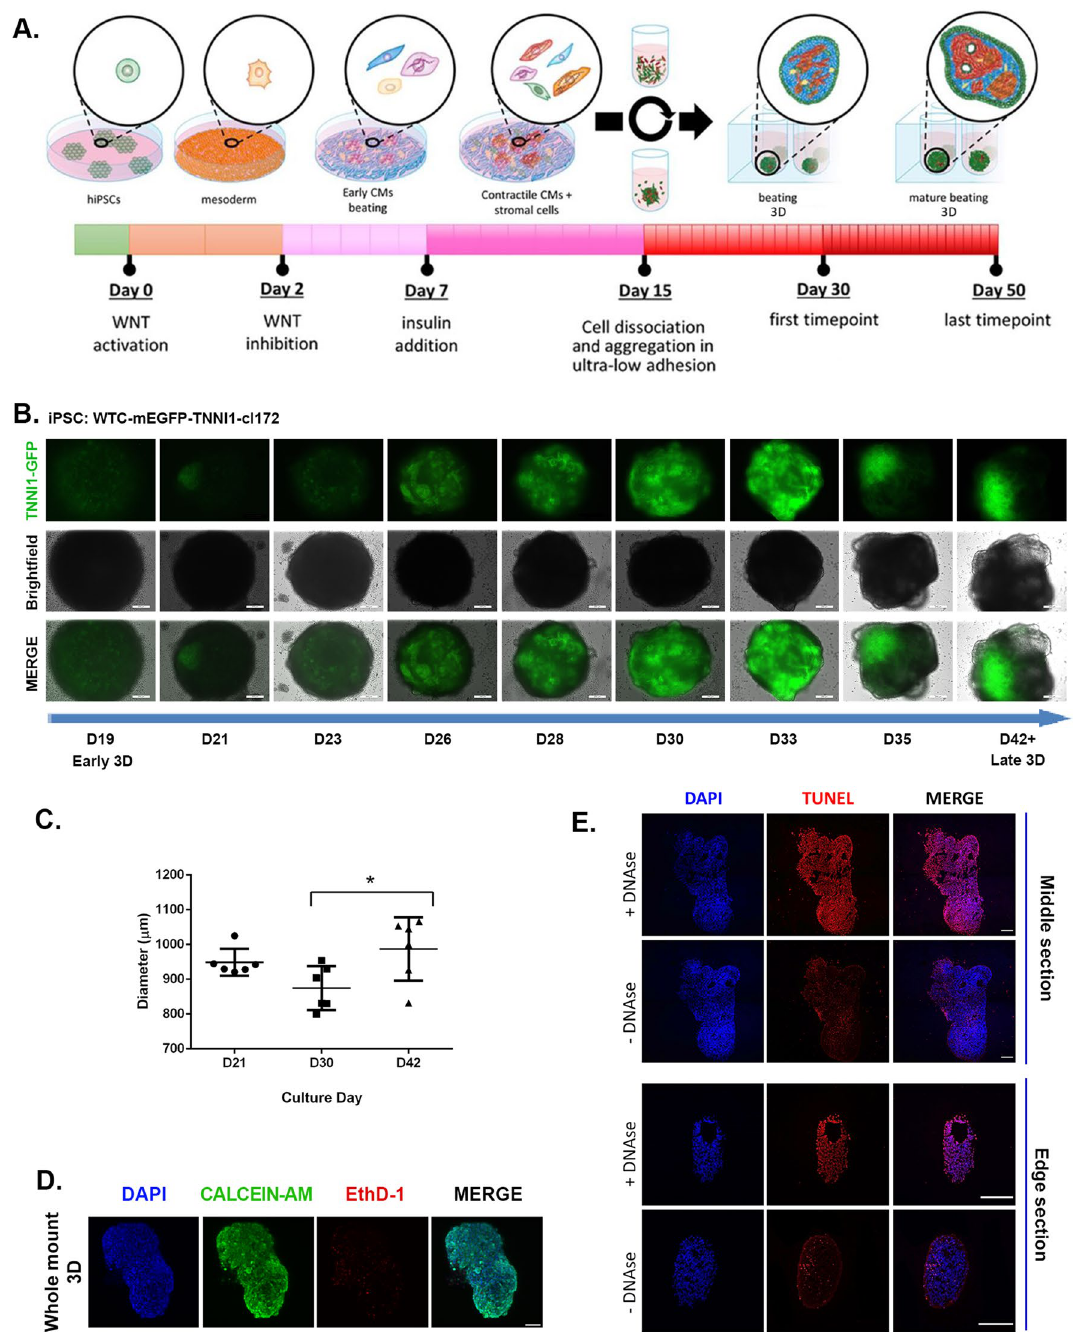
Figure 1. Long-term human cardiac microtissues can be spontaneously generated by scaffold-free conditions in 3D. ( A ) Schematic workflow for the generation and long-term culture of hiPSC derived cardiac microtissues. Warm colours represent cardiomyocyte lineages, while the rest of the colours represent non-myocytes. ( B ) Monitoring spontaneous self-organization of hiPSC-derived cardiomyocytes within 3D microtissues expressing GFP-tagged Cardiac Troponin I reporter over culture time (scale bar = 200 μm). ( C ) Average diameter of 3D long-term cultured cardiac microtissues over time (n = 6, Mean ± SD, Tukey’s multiple comparisons test). ( D ) Cell viability of 3D long-term cultured microtissues with Calcein/AM staining on day 50, green = live, red = dead, blue = DAPI counterstain (Scale bar = 200 µm). ( E ) TUNEL staining (red) depicting apoptotic cells on day 50 3D long-term cultured microtissue cryosections, and positive controls with DNAse I treatment (edge and center). Nuclei were counterstained with DAPI (blue) (scale bar = 200